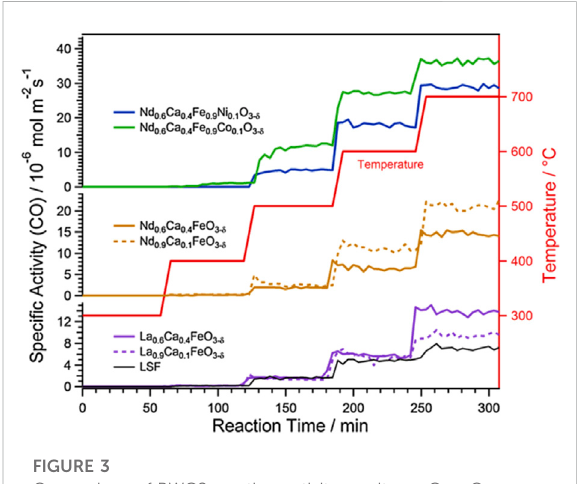
FIGURE 3 Comparison of RWGS reaction activity results on Co-, Ca-, and Ni-doped samples. Reproduced from Lindenthal et al. (2021); Copyright © 2021